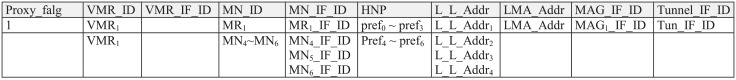
AE-PMIPv6 registration signaling using addressing pool mechanism.